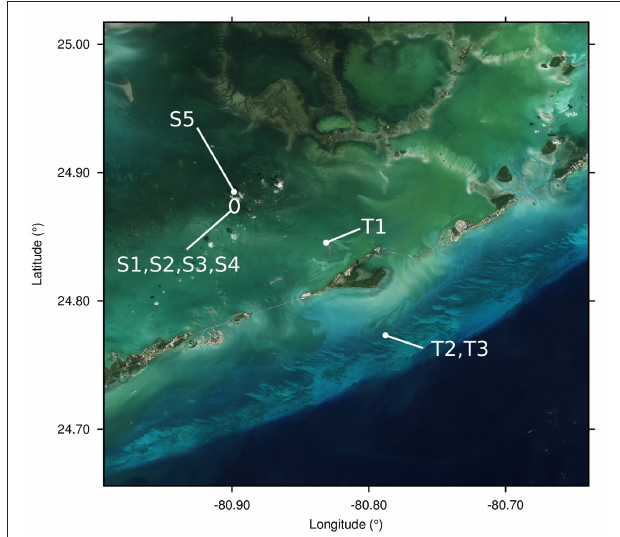
FIGURE 3 | The five Syringodium dominated locations (S1-S5) and three Thalassia dominated locations (T1-T3) where the in situ LAI and depth data points were located. Image produced using Sentinel-2A data from the European Space